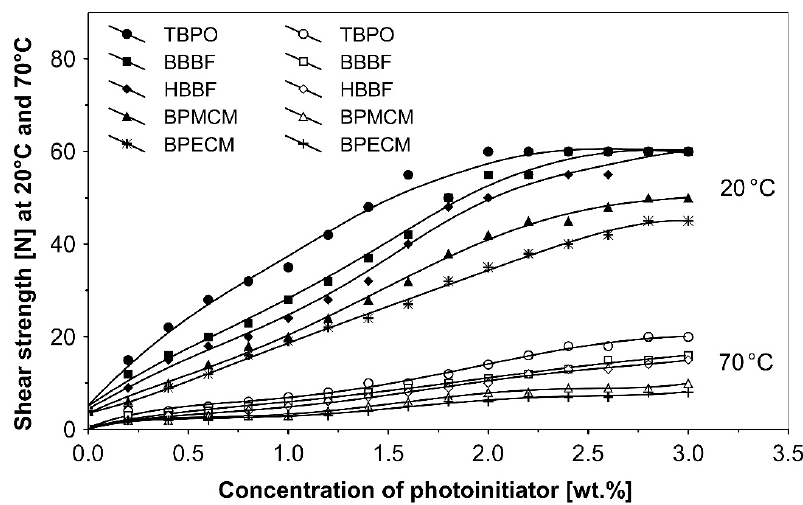
Figure 4. Influence of multifunctional photoinitiators on the shear strength of a UV-crosslinked acrylic PSA.